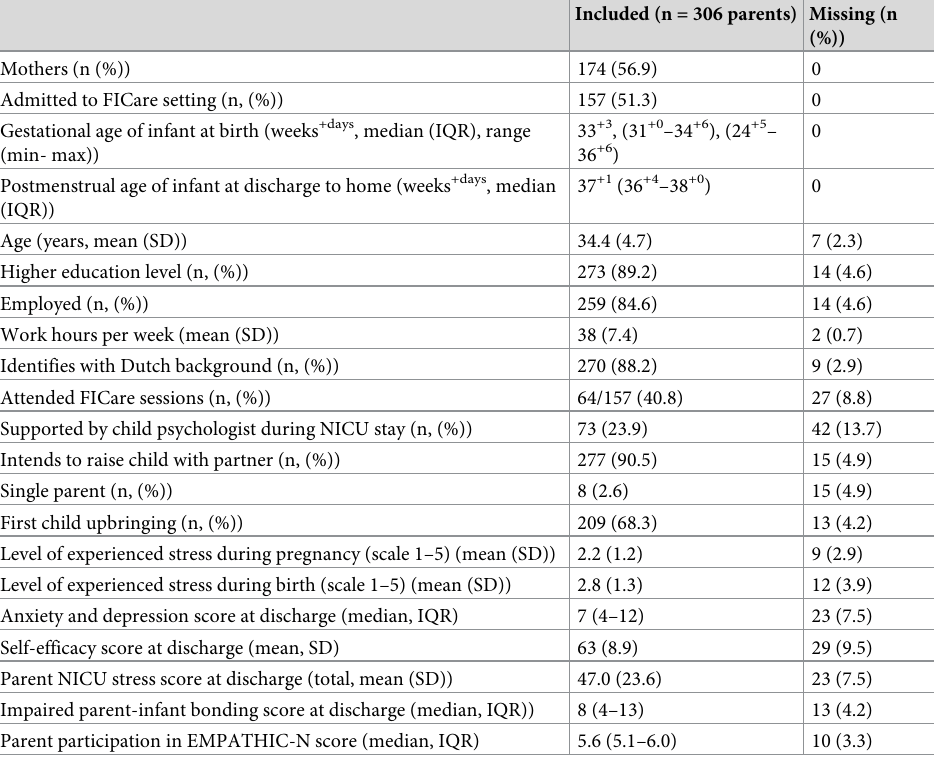
Table 2. Baseline characteristics of the